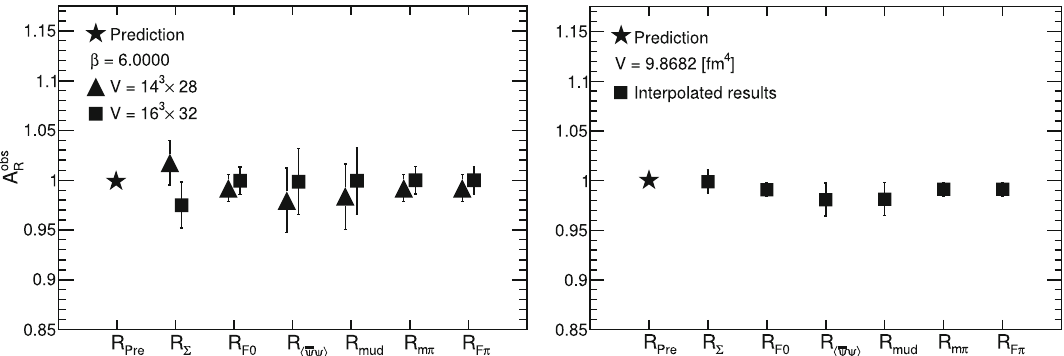
Fig. 19 Comparingthepredictionwiththefittingresultsoftheslopes A obs of β = 6 . 0000 (left) and the interpolated results (right)